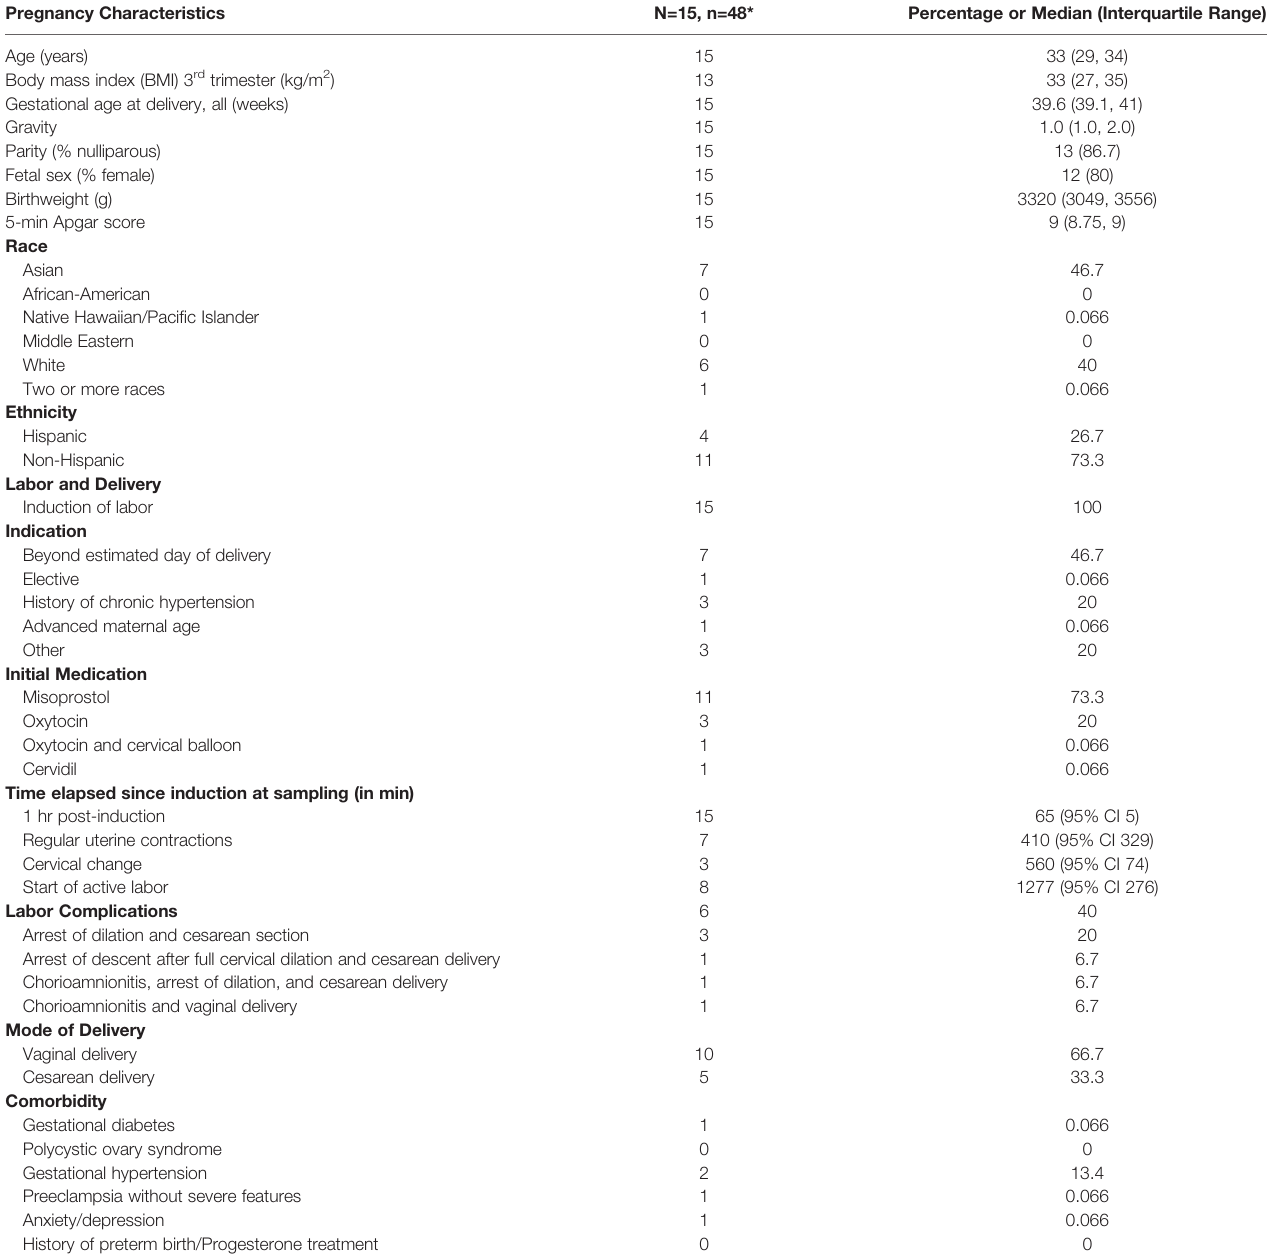
TABLE 1 | Demographic data of the study cohort. Pregnancy